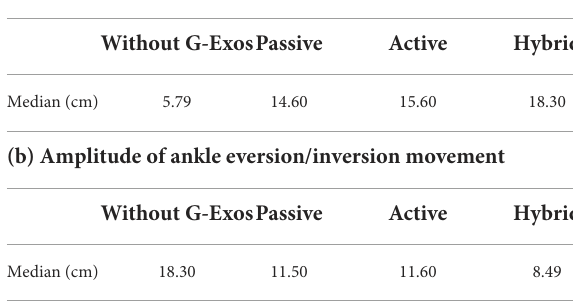
TABLE 4 Comparison of ankle range of motion with and without the use of the G-Exos for the foot drop group. (a) Amplitude of ankle dorsiflexion